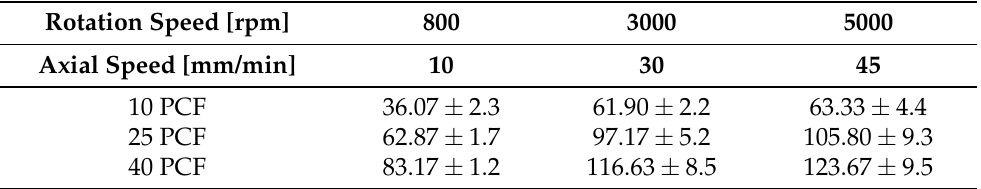
Table 4. Experimentally measured maximum temperature T max [ ◦ C ] for three analysed revolution speeds and three PUR foam densities.